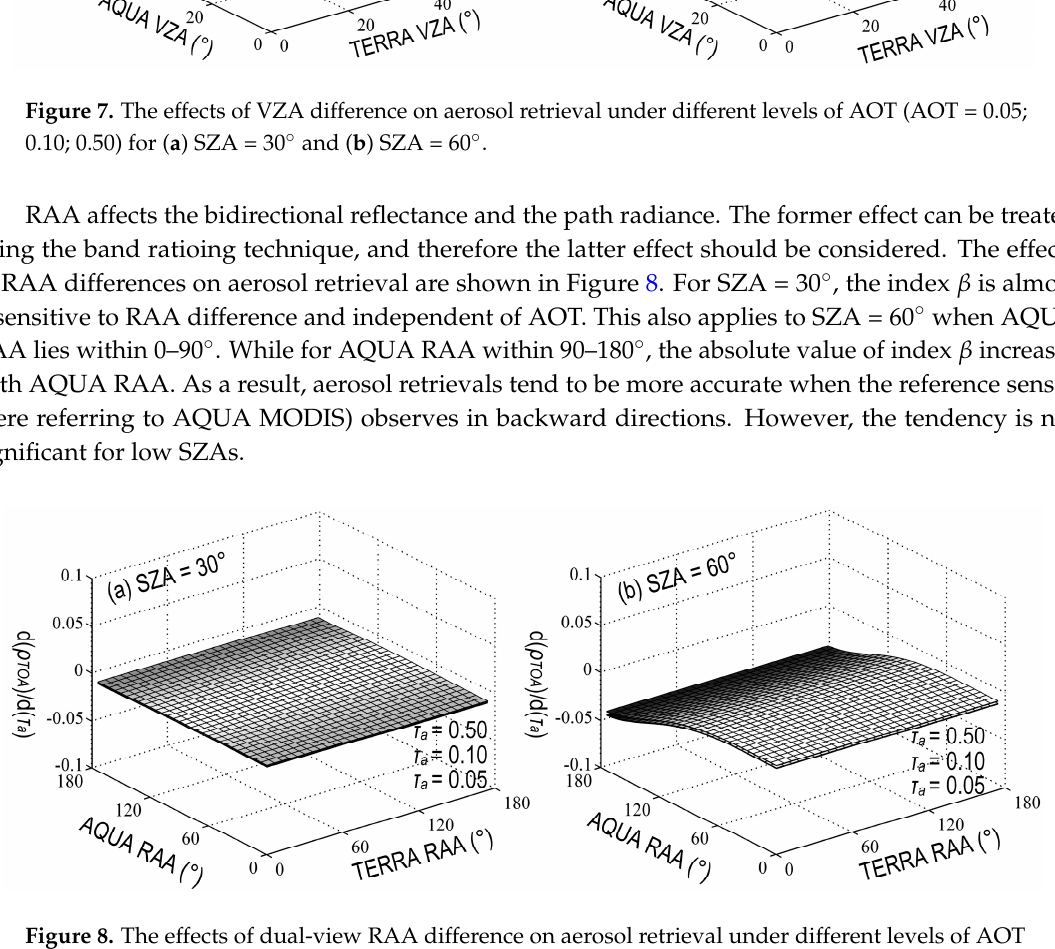
Figure 8. The effects of dual-view RAA difference on aerosol retrieval under different levels of AOT (AOT = 0.05; 0.10; 0.50) for ( a ) SZA = 30° and ( b ) SZA = 60°.